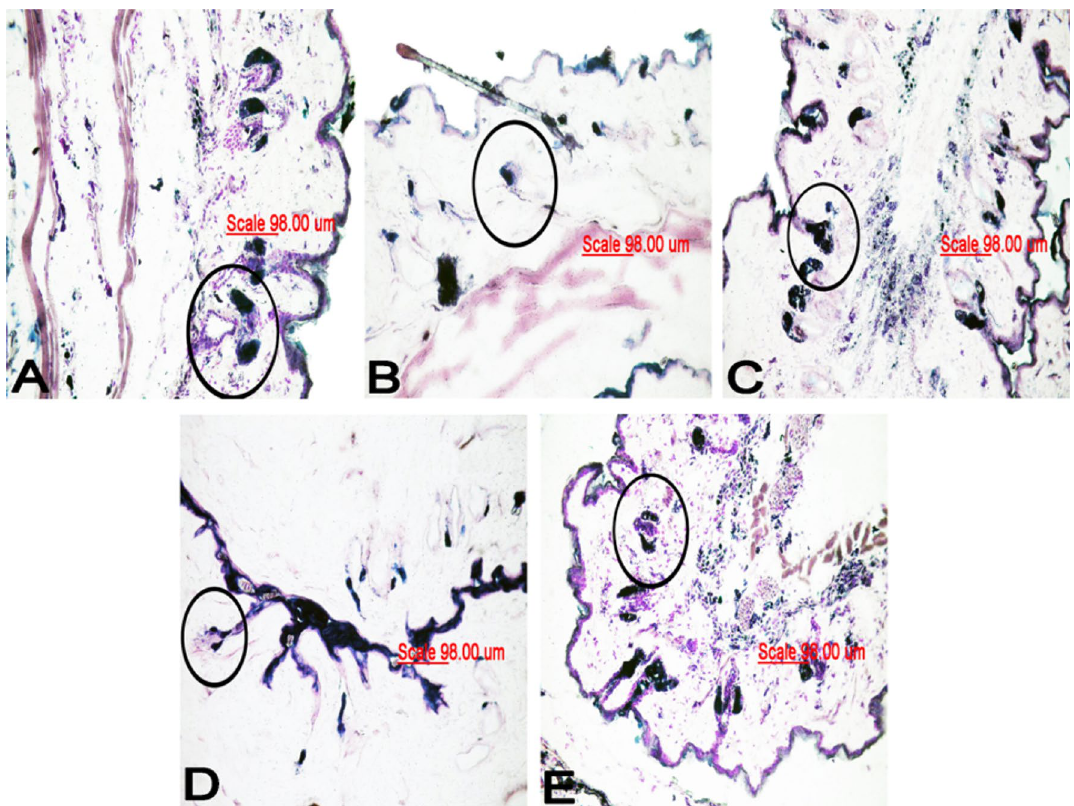
Figure 3. Photomicrographs (×200) of frozen mice tissue sections stained with Sudan Black. Note the presence of a fat spot and intracytoplasmic lipid expression in sebaceous cells. The technique permitted visualization of differences in the size of the sebaceous glands (black circle). ( A ) Control group. ( B ) UD group. ( C ) DS group. ( D ) DNa group. ( E ) DS-Na